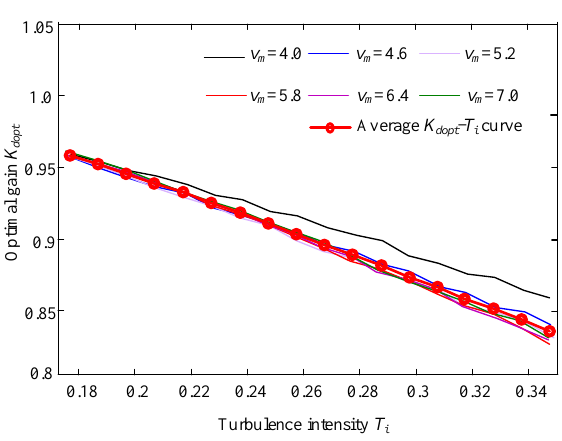
Figure 10. T i - K dopt curves under different mean wind speeds.